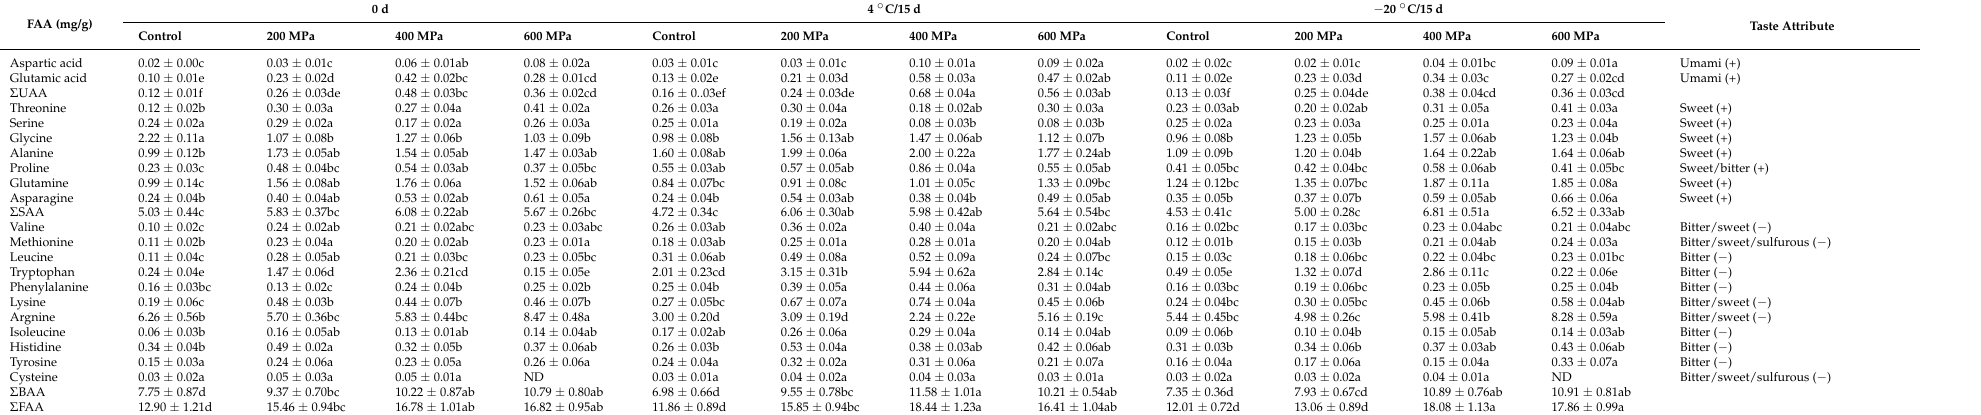
Table 2. The contents and taste attributes of FAAs in red claw crayfish with different